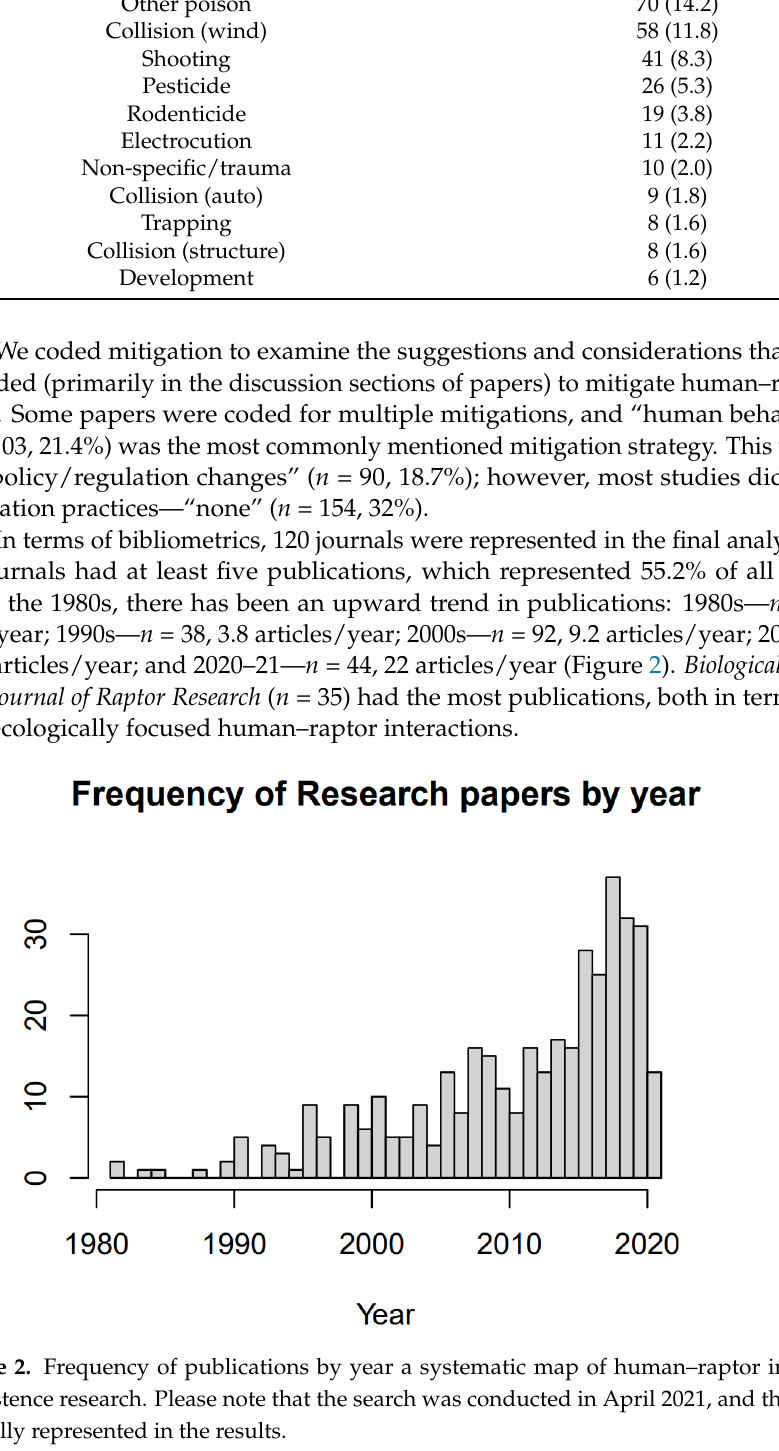
Table 3. Mortality types and frequencies documented within the reviewed human-raptor interac- tion research.